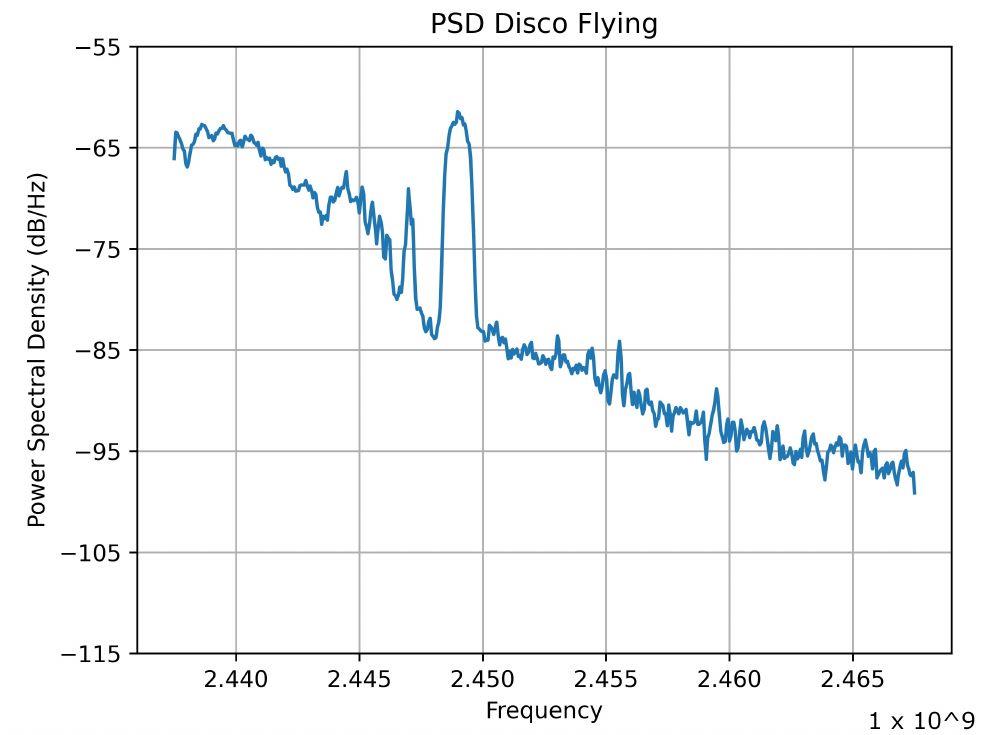
Figure 13. PSD: Disco flying.